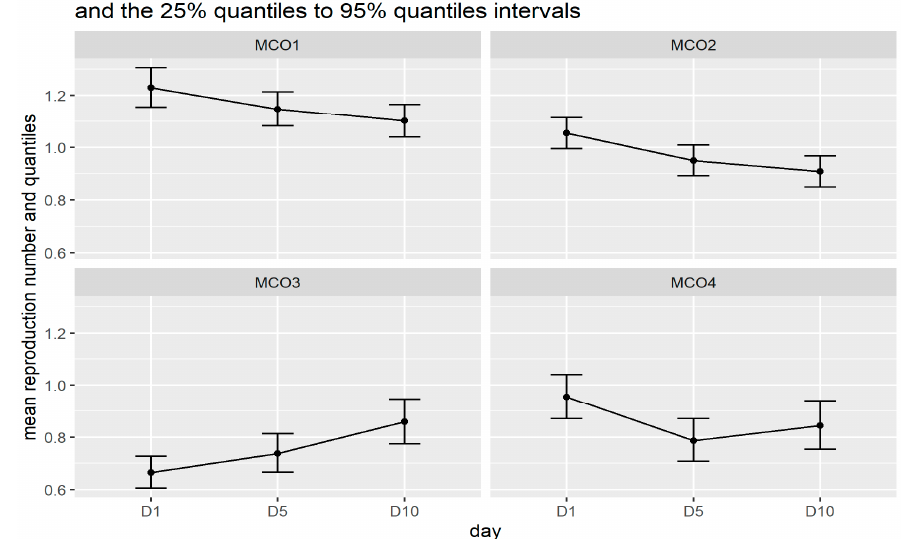
Figure 5. Rt values and their 25% and 95% quartile intervals at D1, D5 and D10 for each MCO phase. Table 2. Mean value of Rt at day 1, day 5 and day 10 for each MCO in Malaysia. Mean Day MCO Rt